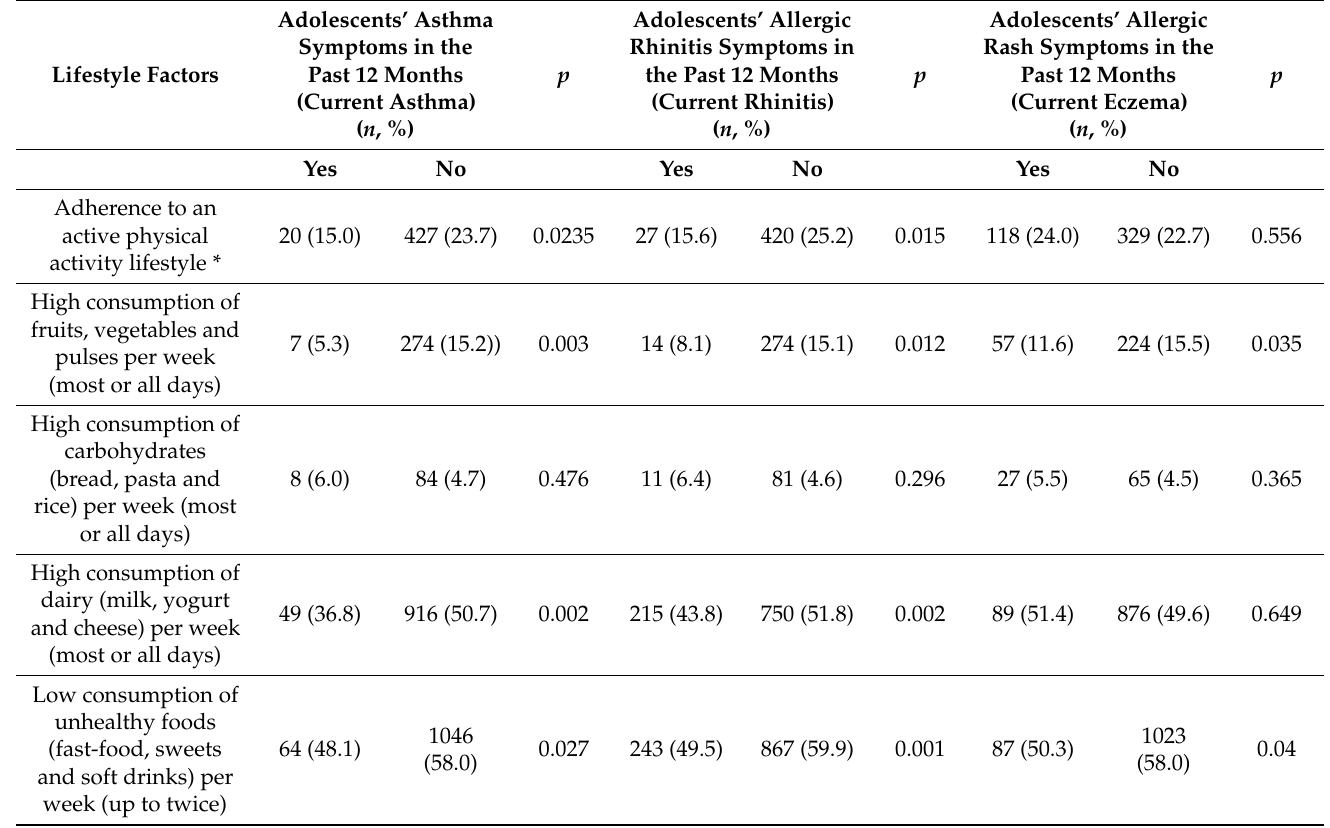
Table 2. Differences in lifestyle factors between adolescents with and without history of atopic diseases in the past 12 months ( n =